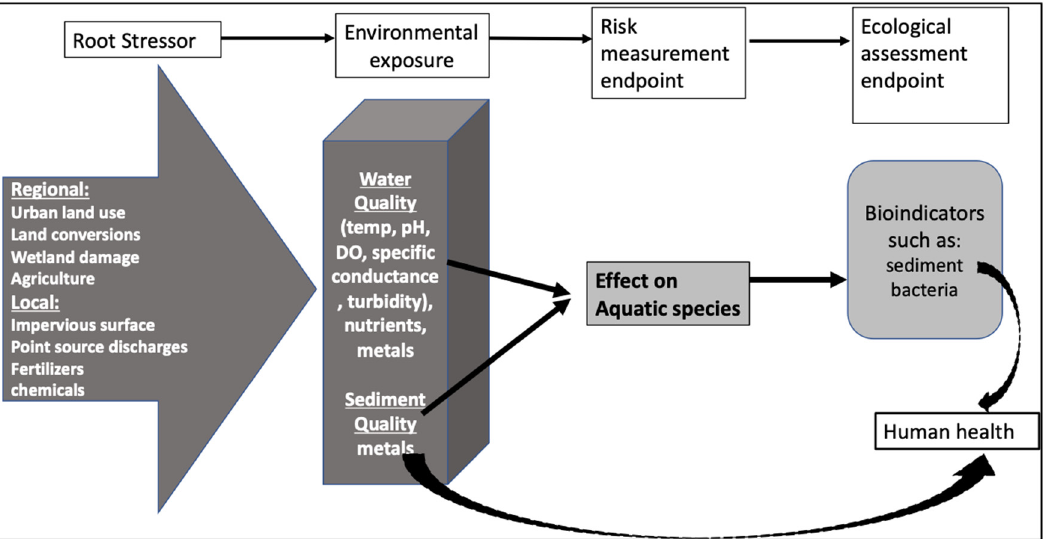
Figure 1. Risk propagation model for watershed-based aquatic ecological risk assessment (adapted from [32,33]).